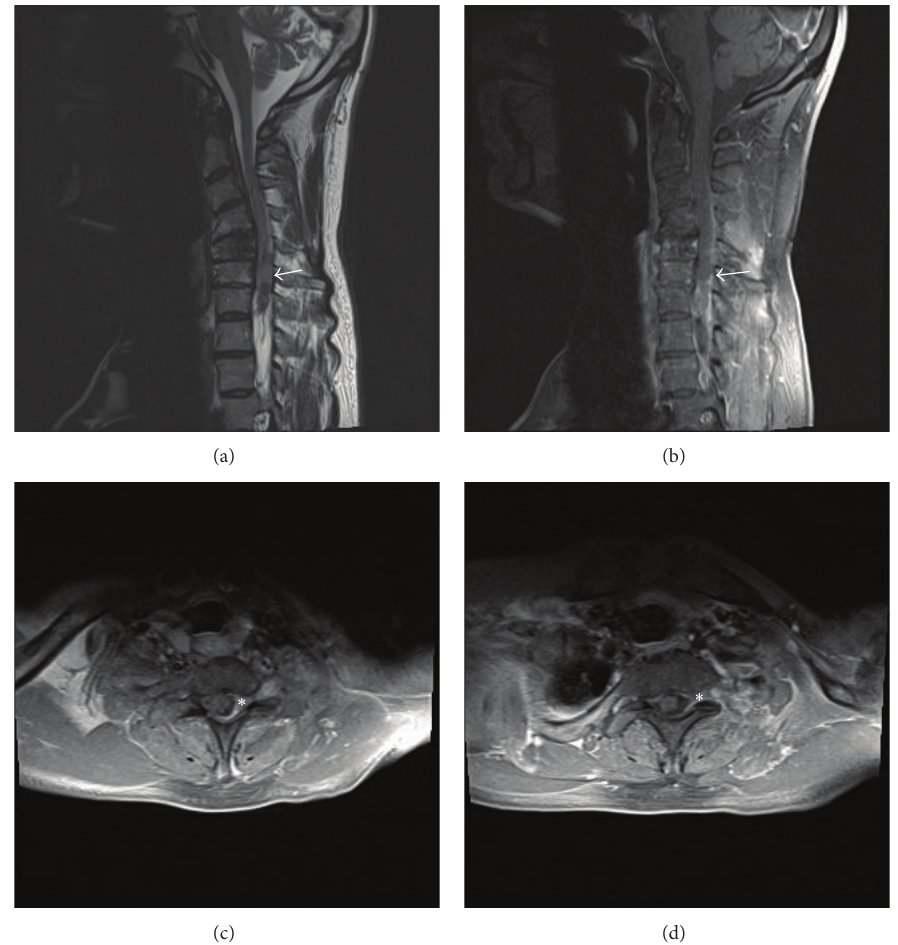
Figure 1: Cervical MRI: (a) midsagittal T2 MRI (TR = 4000, TE = 98) and (b) midsagittal T1 postcontrast (TR = 659, TE = 8.7) imaging of the cervical spine showing a C2–C7 ill-defined extradural mass that is hypointense on T2 and enhances with contrast most predominant at C6-C7. ((c) and (d)) Two axial slices of a preoperative T1 postgadolinium contrast (TR = 591, TE = 7.3) MRI of the cervical spine passing through the C6-C7 level demonstrates an extradural, enhancing mass invading the spinal canal eccentric to the